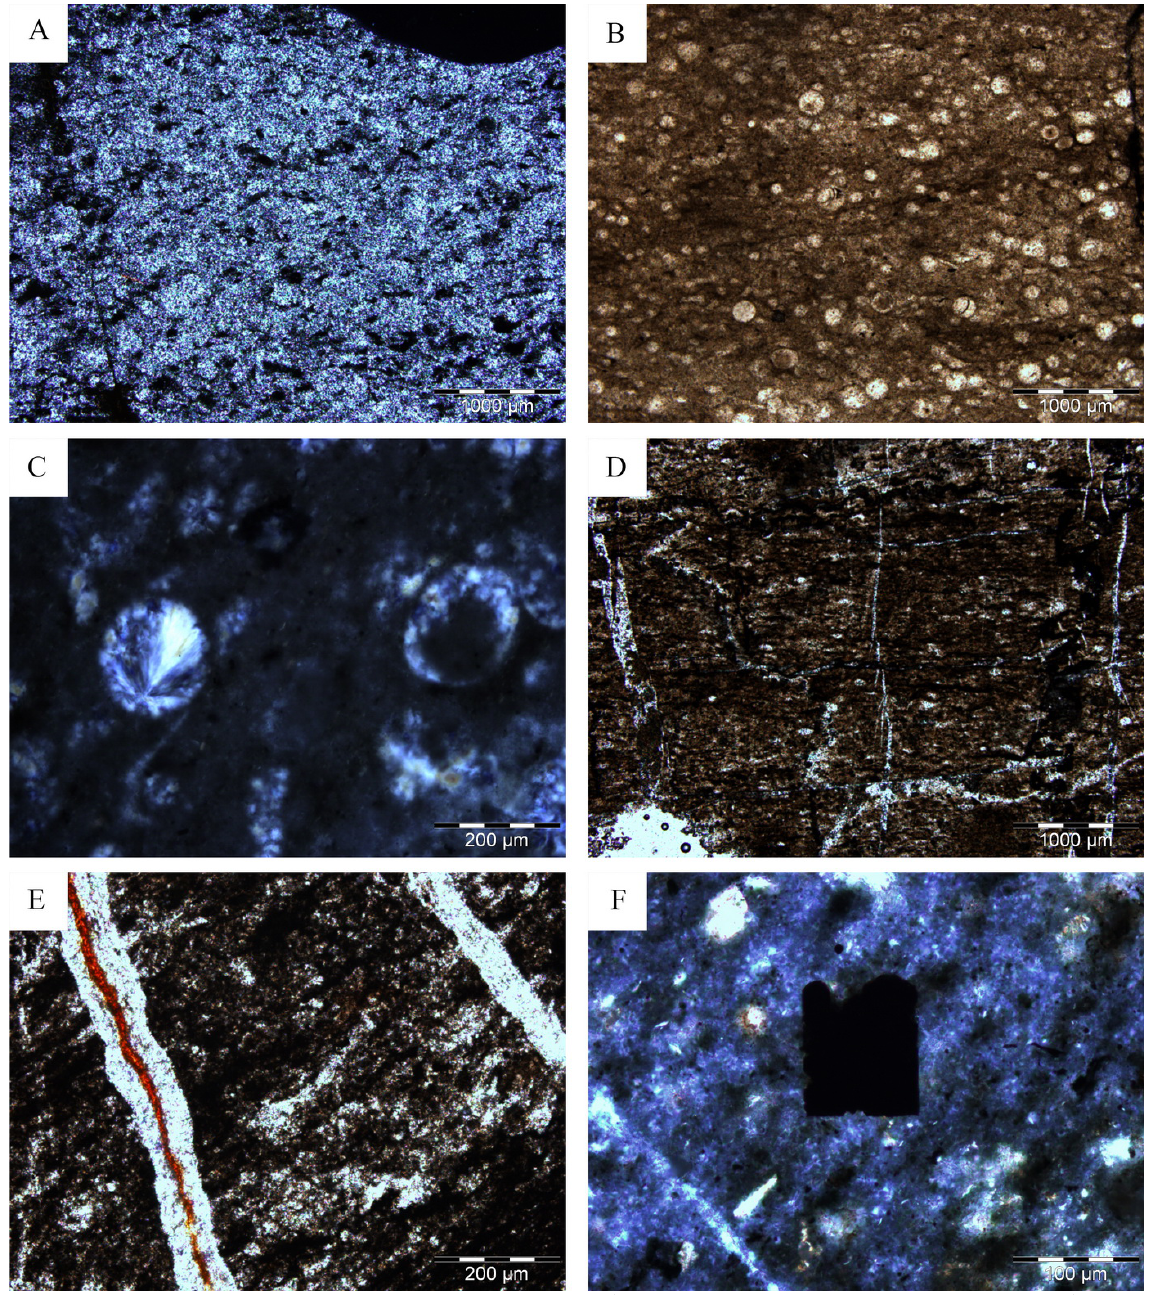
Figure 6: Microscopic characteristics of Vegamián chert: A) Matrix of a Vegamián Type 1 chert at 40x (FON1- 1; cross-polarized light/xpl). It is mostly comprised of quartz, with some inclusions of organic matter. It is difficult to distinguish the radiolarians in polarized light. (scale bar = 1000 μm) B) Matrix of black laminated chert at 40x (RÑO1FON11; plane-polarized light/ppl). A high radiolarian content can be noted. (scale bar = 1000 μm) C) Image of two radiolarians filled with fibrous quartz in a chert at 200x (RÑO1, xpl). (scale bar = 200 μm) D) Matrix at 40x (OLL1-1; ppl). Vertical stylolites can be noted as well as the little transparency of the thin section. (scale bar = 1000 μm) E) Fracture of a chert filled with quartz and hematite (200x) (POL1-1; ppl). (scale bar = 200 μm) F) Detail of a pyrite at 500x (OLL1-1; xpl). (scale bar = 100